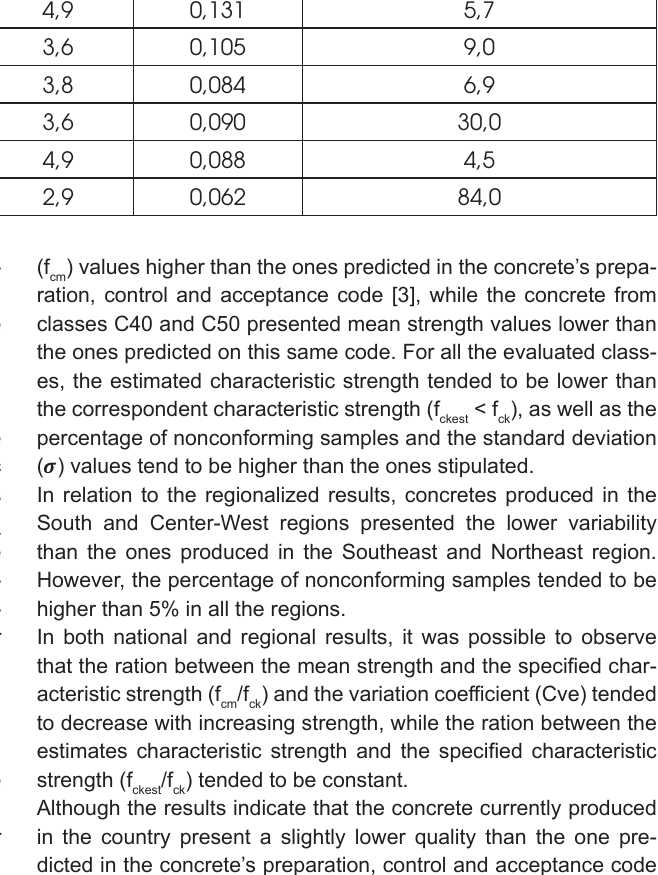
Table 5 Results of the concretes produced in Brazil until 2011 and 2016 Class